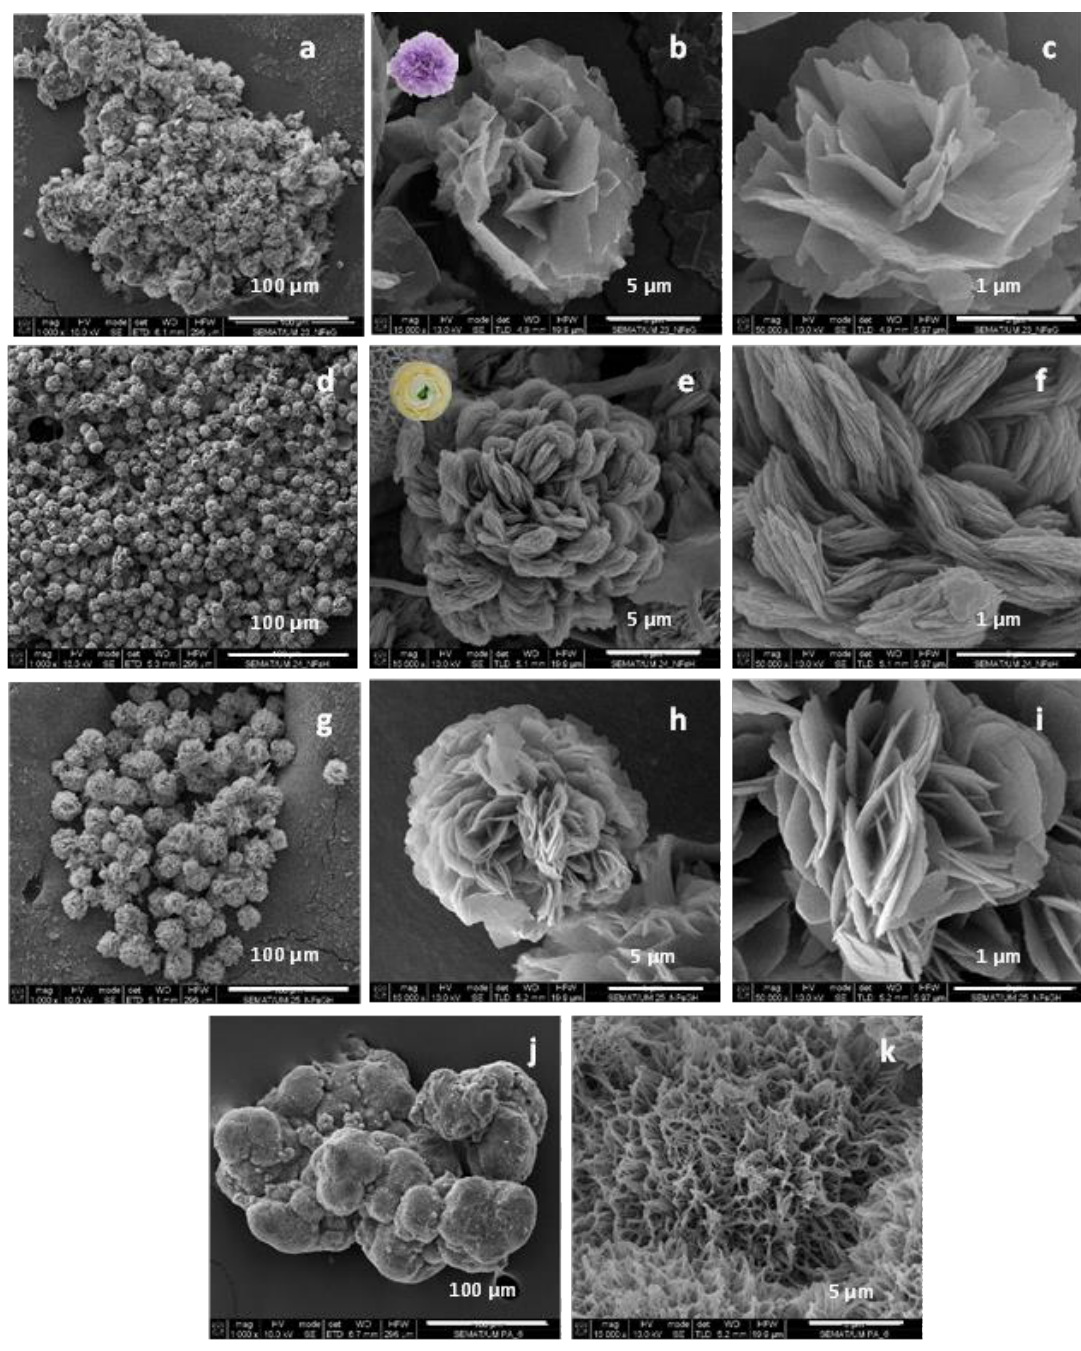
Figure 2. SEM micrographs of: ( a – c ) GOx NF; ( d – f ) HRP NF; ( g – i ) mixed GH NF; ( j , k ) PA6 microparticles. For sample designation and idealized structure see Figure 1.